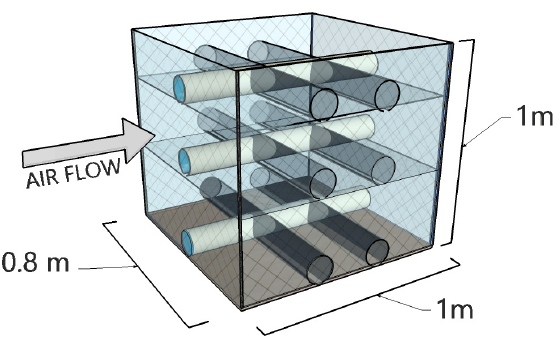
Figure 2. Convective static bed reactor design for bioremediation treatments implementation (Designed by the